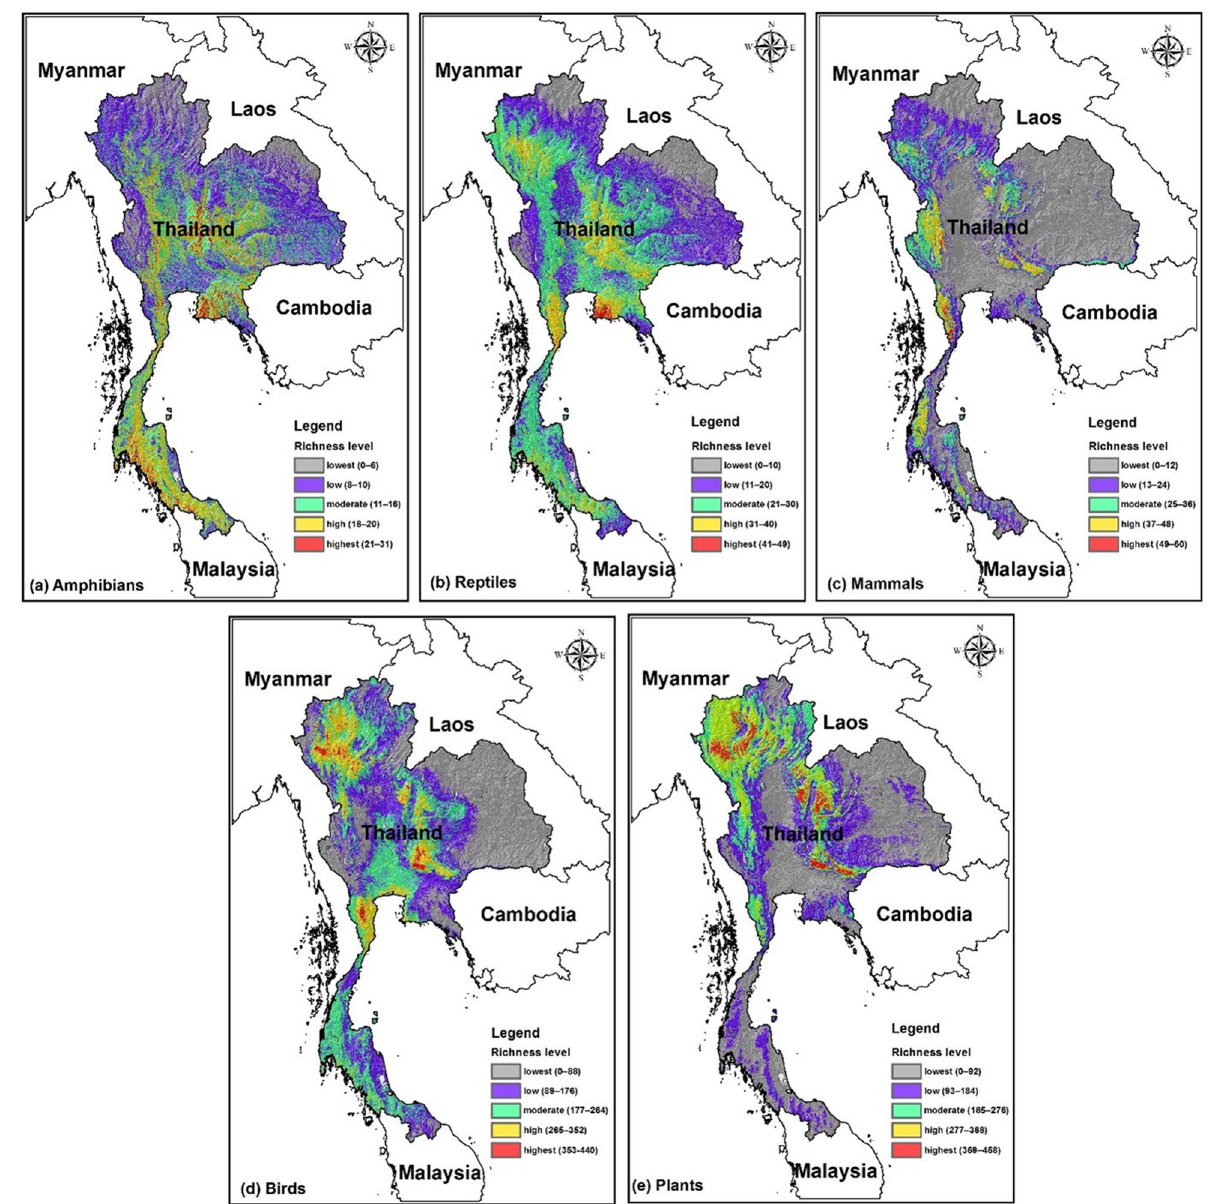
Figure 3. Spatial patterns of predicted species richness levels for each major taxon under current conditions. Maps created in ArcMap 10.5 (https:// suppo rt. esri. com/ en/ produ cts/ deskt op/ arcgis- deskt op/ arcmap/